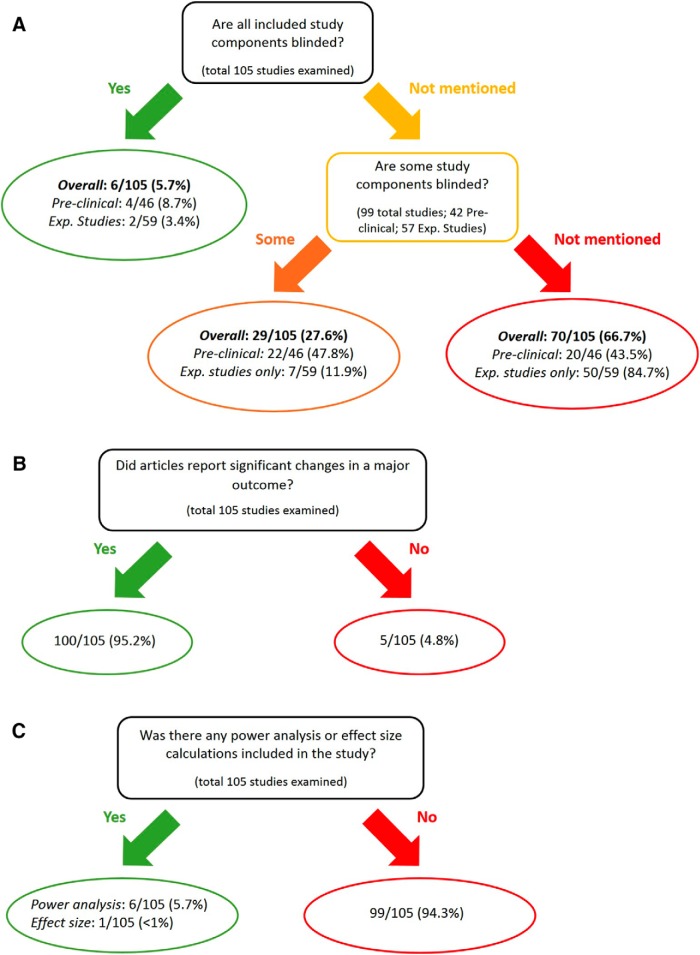
, The majority of ALS studies do not report blinding and/or power analysis. A, The number of ALS studies on the G93A model conducted between May 2015 and May 2016 that reported blinding of their analysis vs those that did not report blinding [6 studies (5.7%) reported all elements blind, 29 studies [27.6%] reported some elements blind, 70 studies (66.7%) did not report blinding]. The analysis is further broken down by studies containing a preclinical component vs purely experimental studies. B, The number of ALS studies that reported statistically significant results vs those that reported no changes [100 studies (95.2%) reported significant results, 5 studies (4.8%) did not]. C, The number of ALS studies that reported power analysis and/or effect size calculations vs those that did not report these data [6 studies (5.7%) reported power analysis, 1 of these (<1%) reported effect size as well, and 99 studies (94.3%) reported neither). See Results.